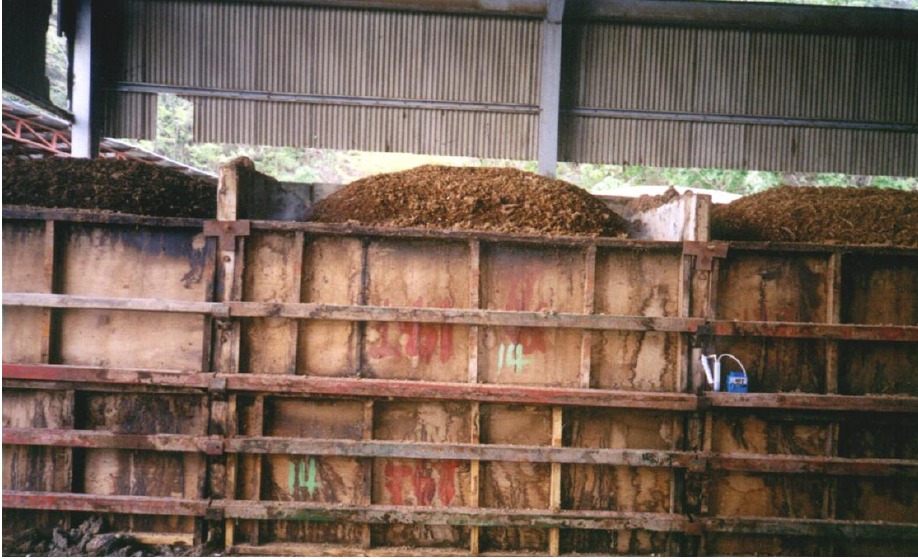
Figure 3. Collection of greenhouse gas samples at the livestock excretions composting facility adopting the stacking method.